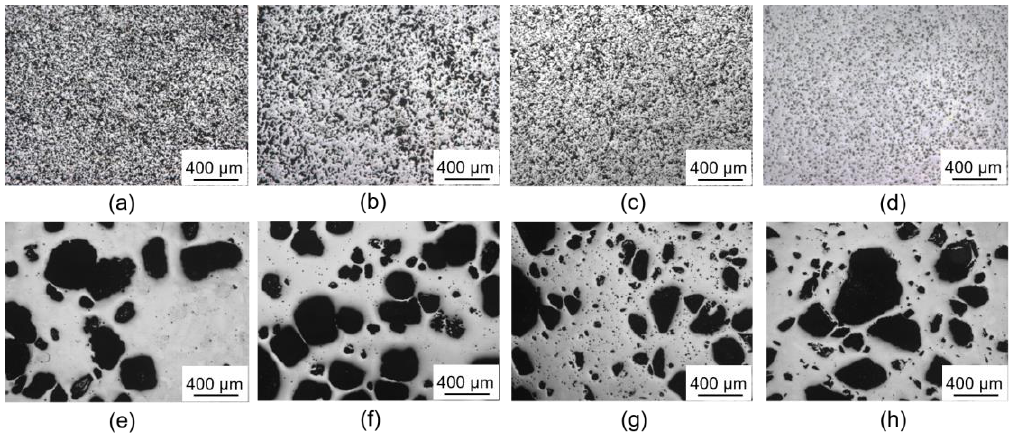
Figure 1. Micrographs corresponding to different processing conditions of evaluated techniques: Loose Sintering, conventional Powder Metallurgy (PM) and space-holder technique: ( a ) 0 MPa and 1000 °C; ( b ) 0 MPa and 1200 °C; ( c ) 13 MPa and 1000 °C; ( d ) 13 MPa and 1200 °C; ( e ) 30 vol.% NaCl; ( f ) 40 vol.% NaCl ( g ) 30 vol.% NH 4 HCO 3 ; and ( h ) 40 vol.% NH 4 HCO 3 . All of the samples have been sintered for 2 h under high vacuum (~10 −5 bar).